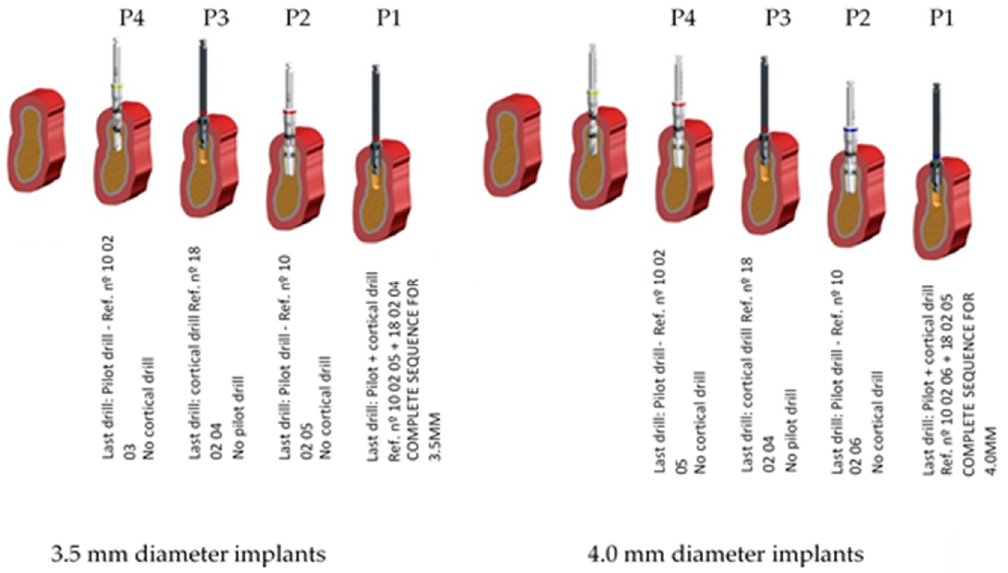
Figure 3. Three-dimensional morphology for P1, P2, P3 and P4 sequences of preparation sites for 3.5- and 4.0-mm diameter implants.